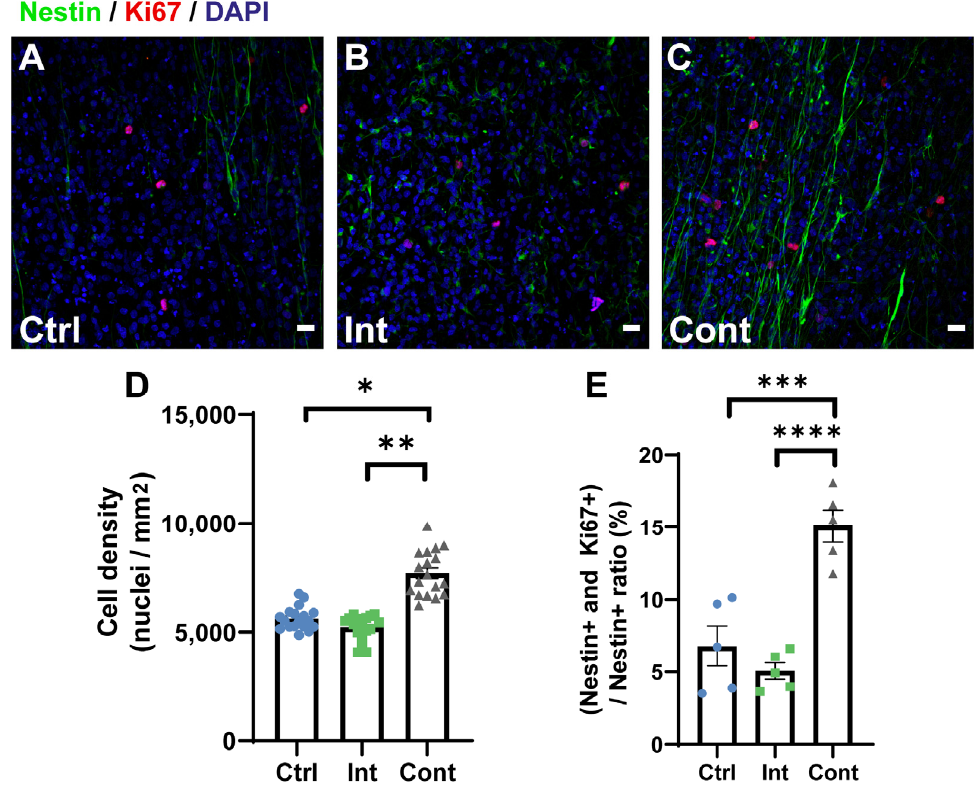
Figure 2. ( A – C ): representative images of immunocytochemistry staining for Nestin (green), Ki67 (red) and DAPI (blue) of the control ( A ), intermittent stimulation ( B ), and continuous stimulation ( C ) groups. Scale bars: 20 µm. ( D , E ): Quantification results of cell density and embryonic proliferating cells percentage ( Nestin + and Ki67 +/ Nestin +) for the control (Ctrl), intermittent stimulation (Int), and continuous stimulation (Cont) groups after 7 days of differentiation culture. ( D ) Cell density quantification results (Ctrl: 5,632 ± 122 nuclei/mm 2 ; Int: 5,226 ± 134 nuclei/mm 2 ; Cont: 7,702 ± 243 nuclei/mm 2 ). Statistical differences tested by a nested one-way ANOVA. ( E ) Percentage of embryonic proliferating cells (Ctrl: 6.8 ± 1.4 %; Int: 5 ± 0.6 %; Cont: 15.1 ± 1.1 %). Statistical differences tested by ordinary one-way ANOVA. Data are expressed as mean ± SEM. * p < 0.05; ** p < 0.01; *** p < 0.001; **** p < 0.0001.